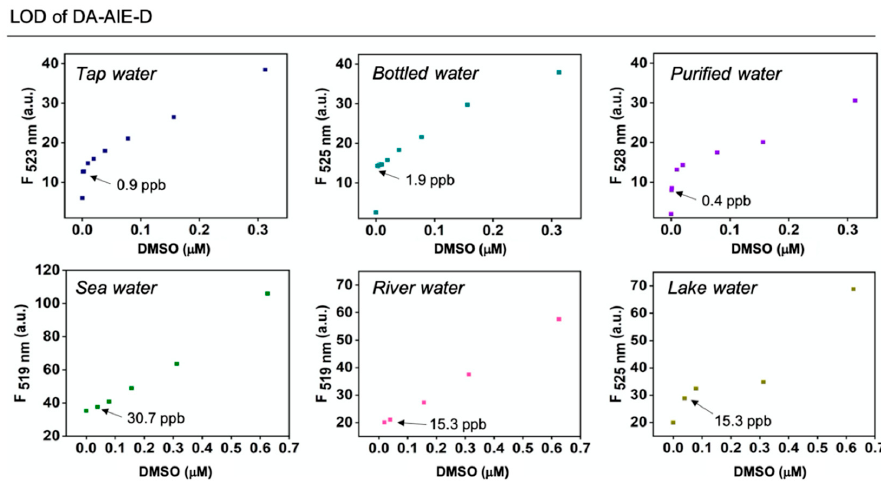
Figure 8. Detection limit for the DMSO in real water samples. A plot of emission intensity of DA-AIE-D (10 μ M) in tap water, bottle water, purified water, sea water, river water, and lake water, in the presence of DMSO (0–0.625 µ M) at 25 ◦ C. The emission spectrum was measured under excitation at the maximum absorption wavelength. The mean value of detection limit (ppb unit) was represented and derived from triplicate